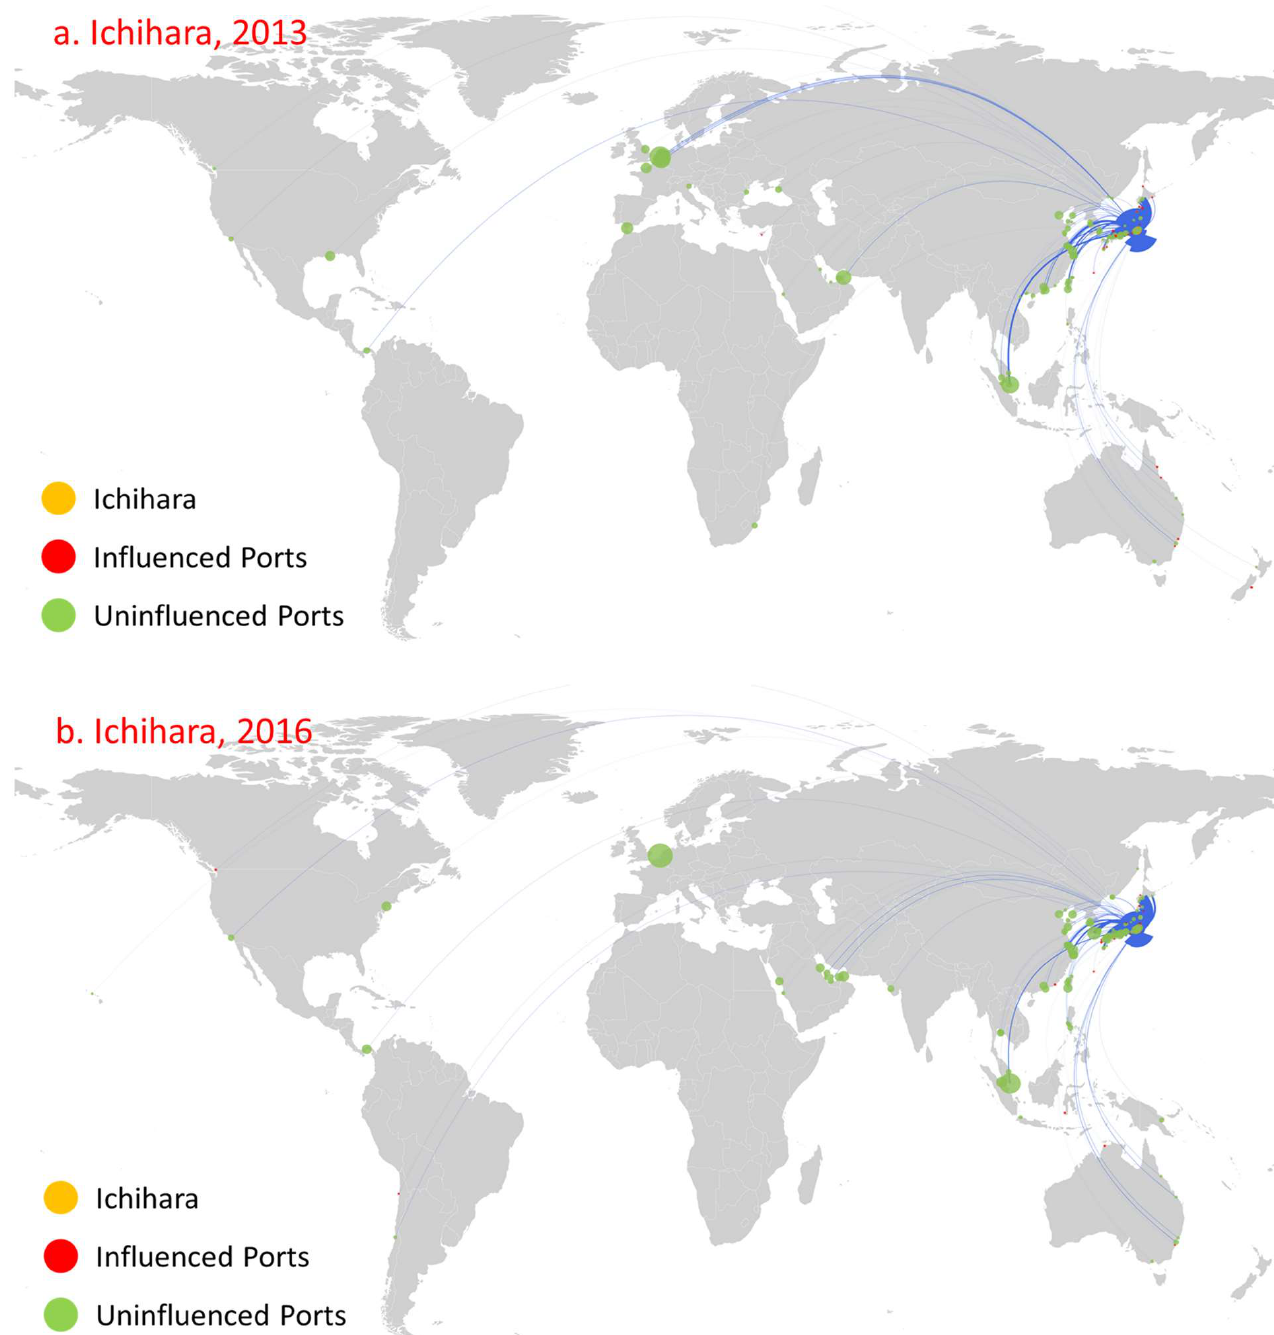
Figure 12. Influence diffusion at the first stage: Ichihara.